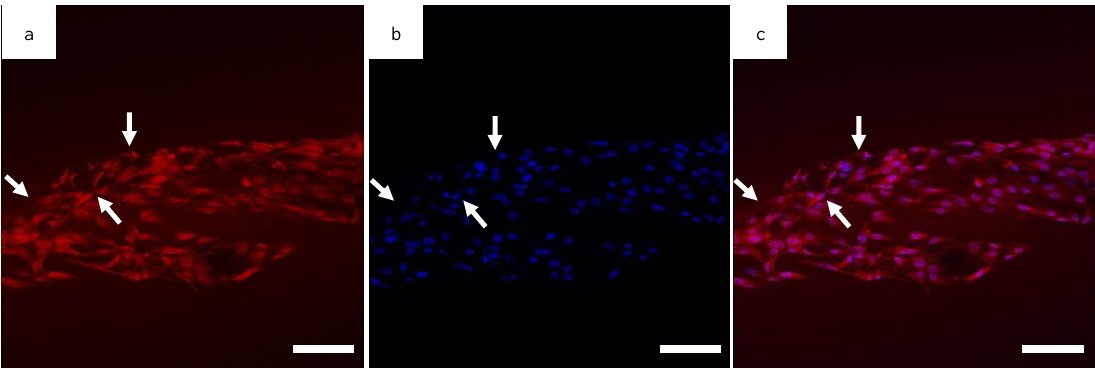
Figure 8. Confocal images of the ( a ) cytoplasm, ( b ) DAPI, and ( c ) composite image for MG63 cells on the HOUSteon. The HOUSteon fractured prior to cell adhesion, and cell migration is visible on the bridging PCL fibers (arrows). Scale Bar is 100 μm.